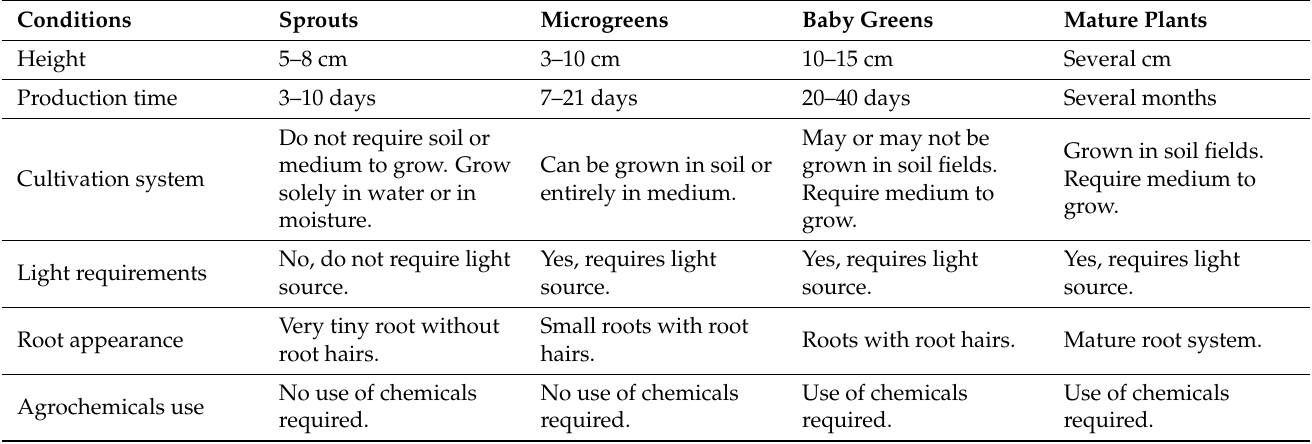
Table 1. Comparison of sprouts, microgreens, baby greens, and mature plants